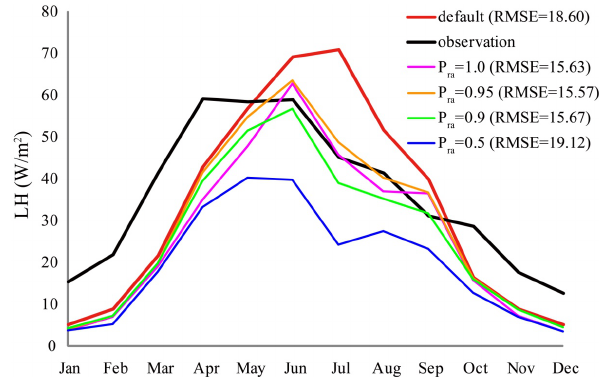
Figure 2. Simulated heat fluxes using the posterior estimates of parameters with monthly 802 Fig. 2. Simulated heat fluxes using the posterior estimates of param- observations at the US-ARM site. 803 eters with monthly observations at the US-ARM